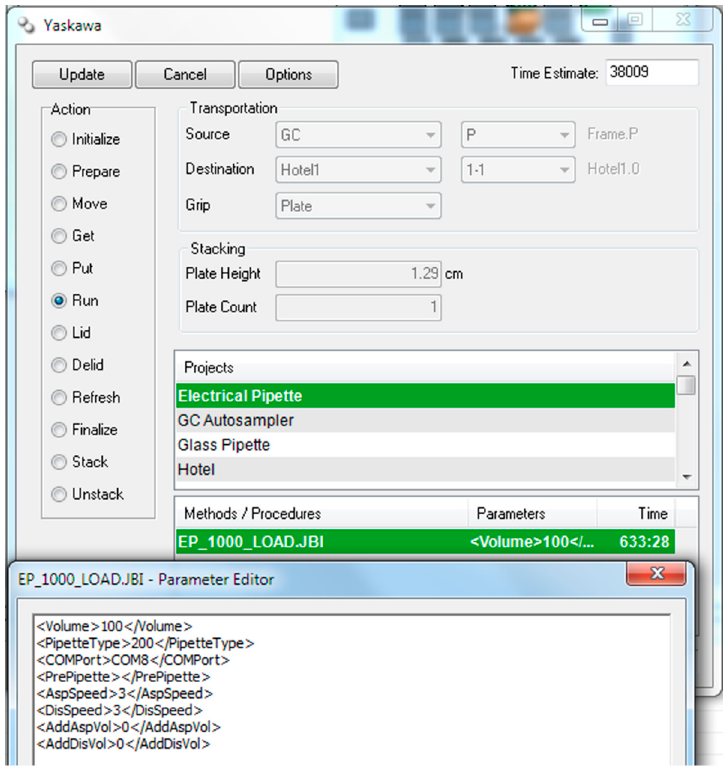
Figure 11. Parameter editor inside a run method.